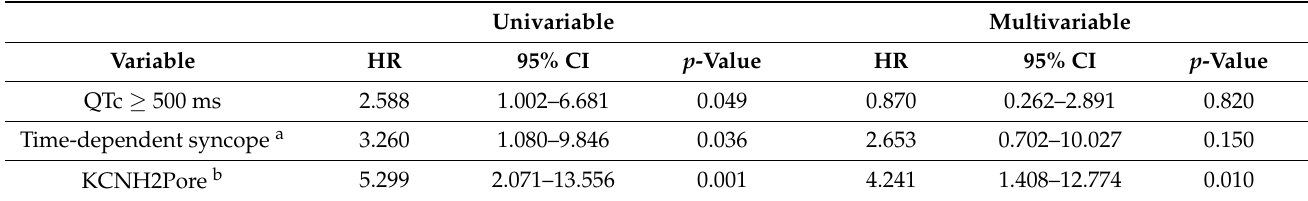
Table 4. Cox regression model: risk factors for MAE with KCNH2Pore. Univariable